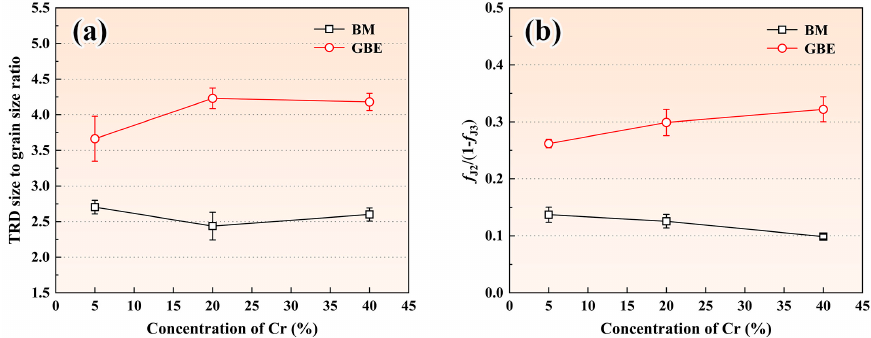
Figure 7. Variations of GBE parameters, v ( a ) and f J2 /(1- f J3 ) ratio ( b ), in the BM and GBE Ni-Cr alloy samples with the Cr content.